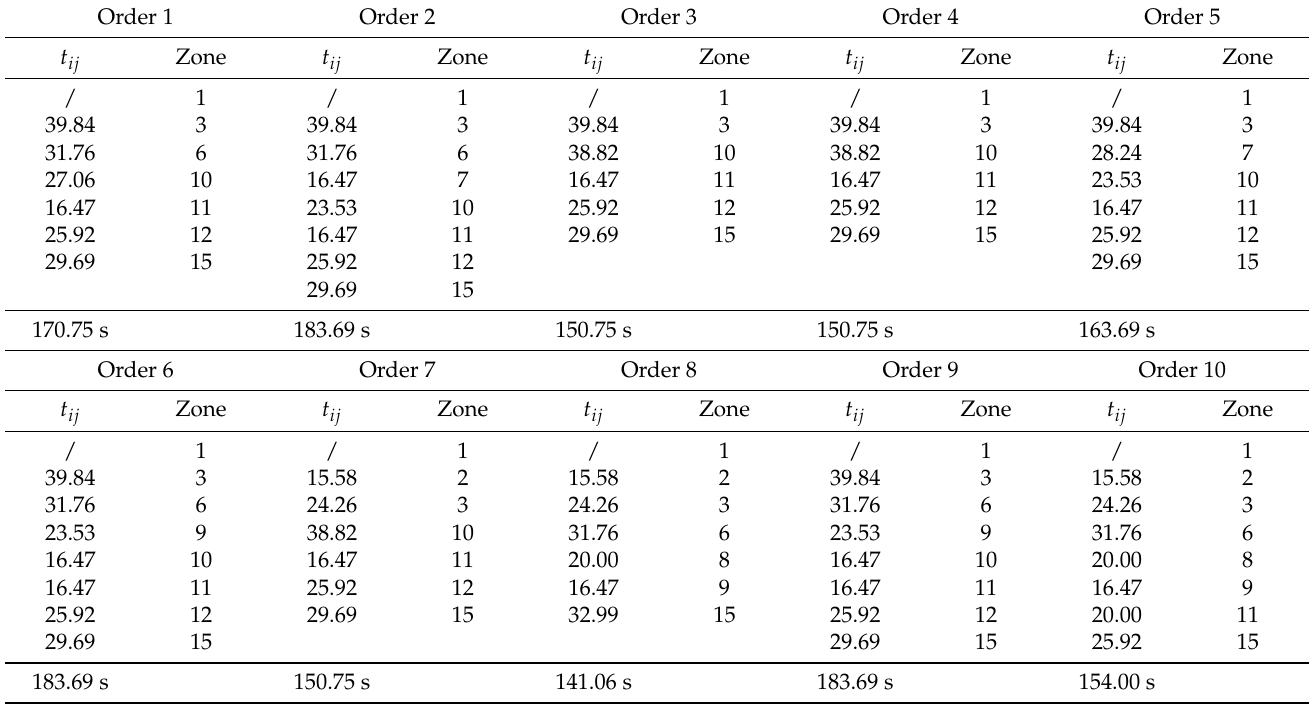
by sorting the vertices in ascending order in terms of priority score. Simulation of travel times for the BOPS orders with the optimal SOP solution are reported in Table